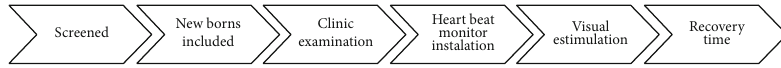
Figure 2: Timeline of the 6 data collection steps.